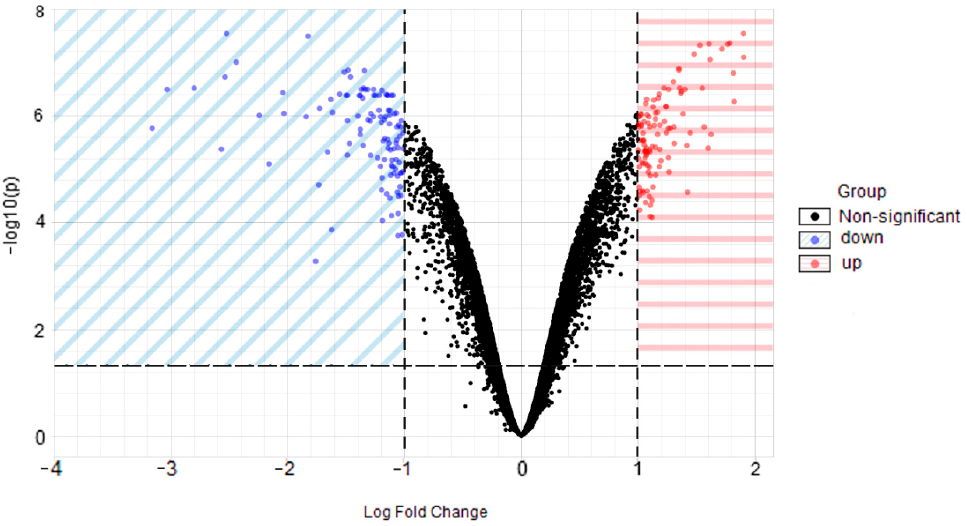
Figure 2. Volcano plot of all genes detected in the microarray. Each dot represents a gene. Dashed lines divide areas of down- and upregulated genes. The X-axis is log2-base fold change, and Y-axis is − log10-base adjusted p -value.